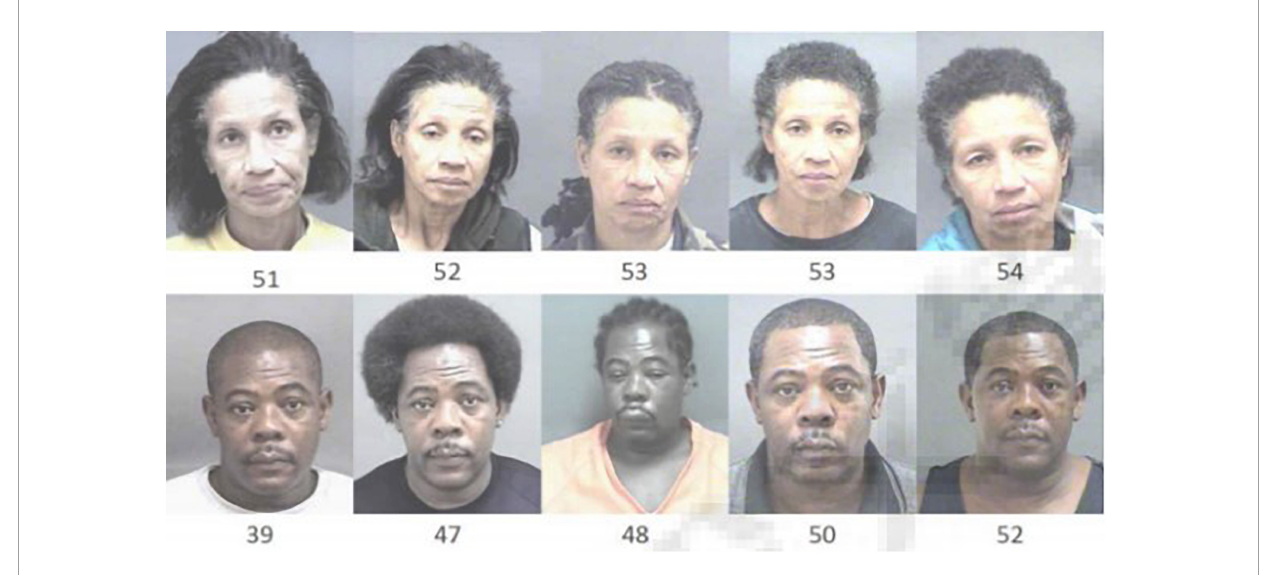
FIGURE4 Images in the MORPH Album II